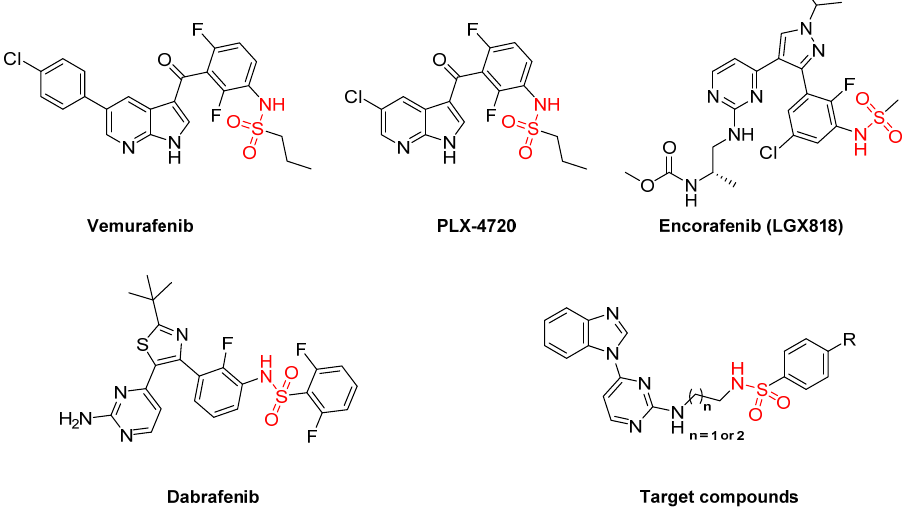
Figure 1. Structures of known sulfonamide-based V600EBRAF inhibitors and the new target com- pounds (sulfonamide moiety in red colour).